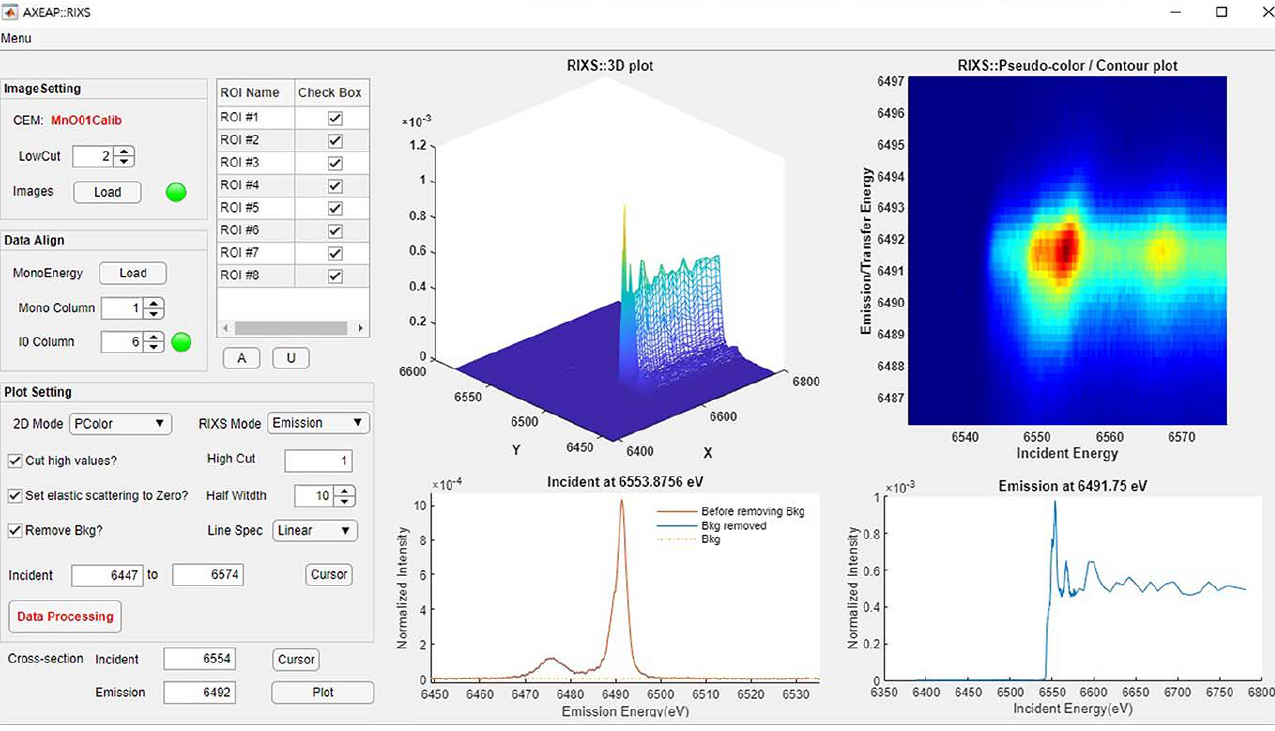
Figure 7 A screen shot of the RXES window with the four plots of XES (Mn K (cid:2) 1,3 ) and XANES (Mn K -edge) of MnO for eight ROIs. The 3D XANES image is